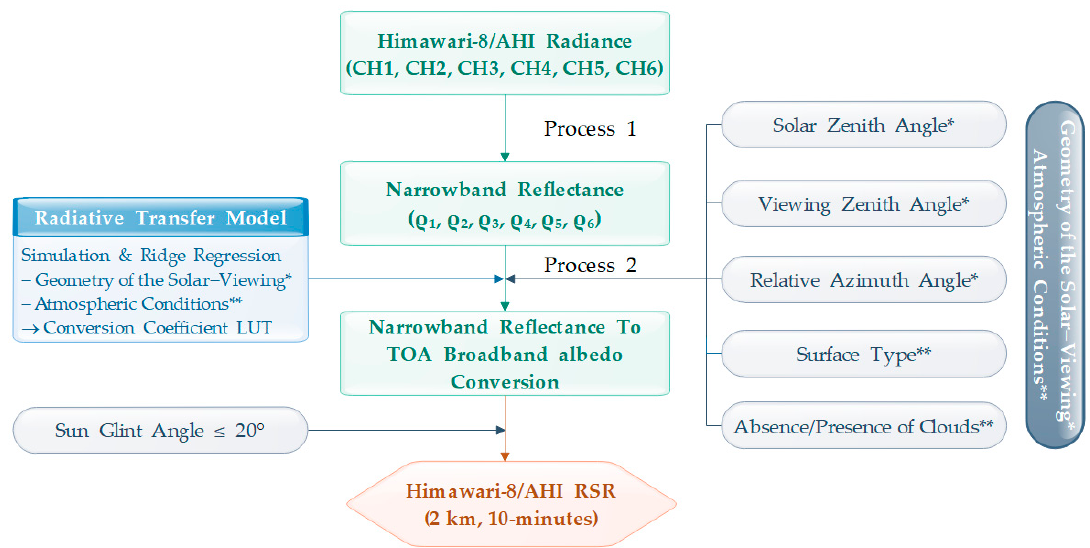
Figure 2. Flow chart of the retrieval algorithm for RSR. Reflectance converted from radiance from each shortwave channel (CH) (Process 1) is used to retrieve RSR using regression coefficients look-up-table (LUT) according to geometry of the solar-viewing (SZA, VZA, and RAA) and atmospheric conditions (surface type and absence/presence of clouds) (Process 2). These regression coefficients were calculated using results from the radiative transfer model (SBDART), which considered geometry of the solar-viewing and atmospheric conditions, and a ridge regression model.